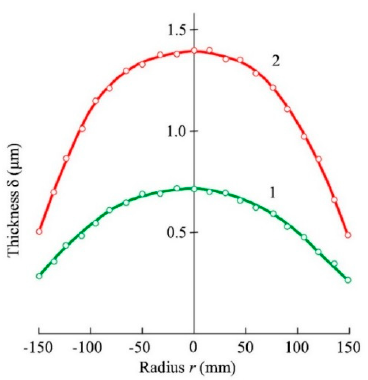
Figure 6. Dependence of the film thickness δ on the distance r from the substrate center. 1—the argon pressure p = 0.4 Pa, the voltage between the hollow cathode and the target U t = 0, the discharge current in the anode circuit I d = 1.8 A. 2—the voltage U t = 2 kV, the current I d = 1.8